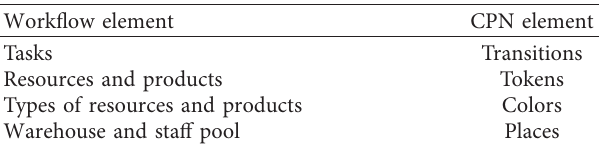
Table 4: Mapping between case and